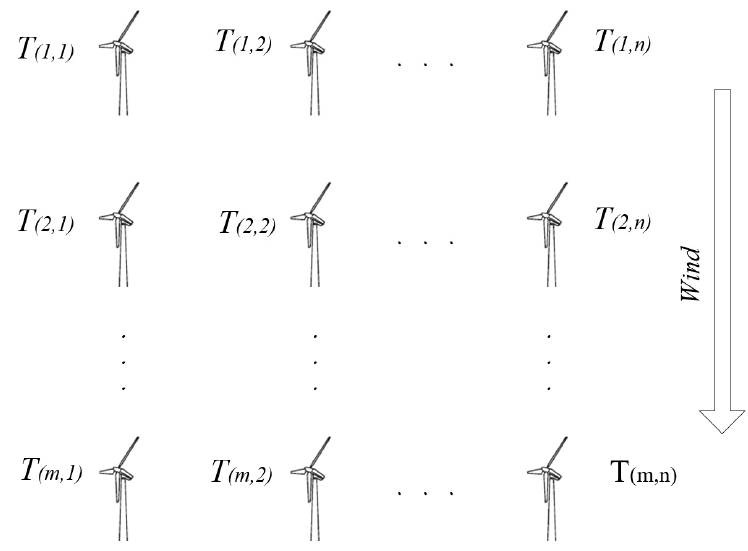
Figure 1. The layout model of an offshore wind farm (OWF).